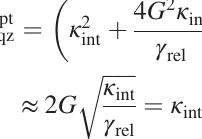
FIG. 11. Scaling of the Wineland parameter ξ 2 as a function of R collective cooperativity C . The blue curve corresponds to ξ 2 rel R calculated by evolving the full (nonlinear) mean-field equations of motion for the dissipative system (see Appendix B). Here κ 500 g , γ 0 . 04 g , giving η 0 . 2 . The number N of int ¼ rel ¼ rel ¼ spins is changed in order to vary C . At each blue point, both r rel are optimized in order to minimize ξ 2 . The orange and κ sqz R dashed curve shows the corresponding fit (calculated over the three data points with the largest C ). The black dashed line rel describes the optimized squeezing of the engineered bosonic reservoir. The solid black line shows an ideal Heisenberg scaling 2 = ð N þ 2 Þ . Finally, the black dotted curve shows the OAT scaling as calculated in Ref.